Question: Condense the content of this figure into a single sentence.
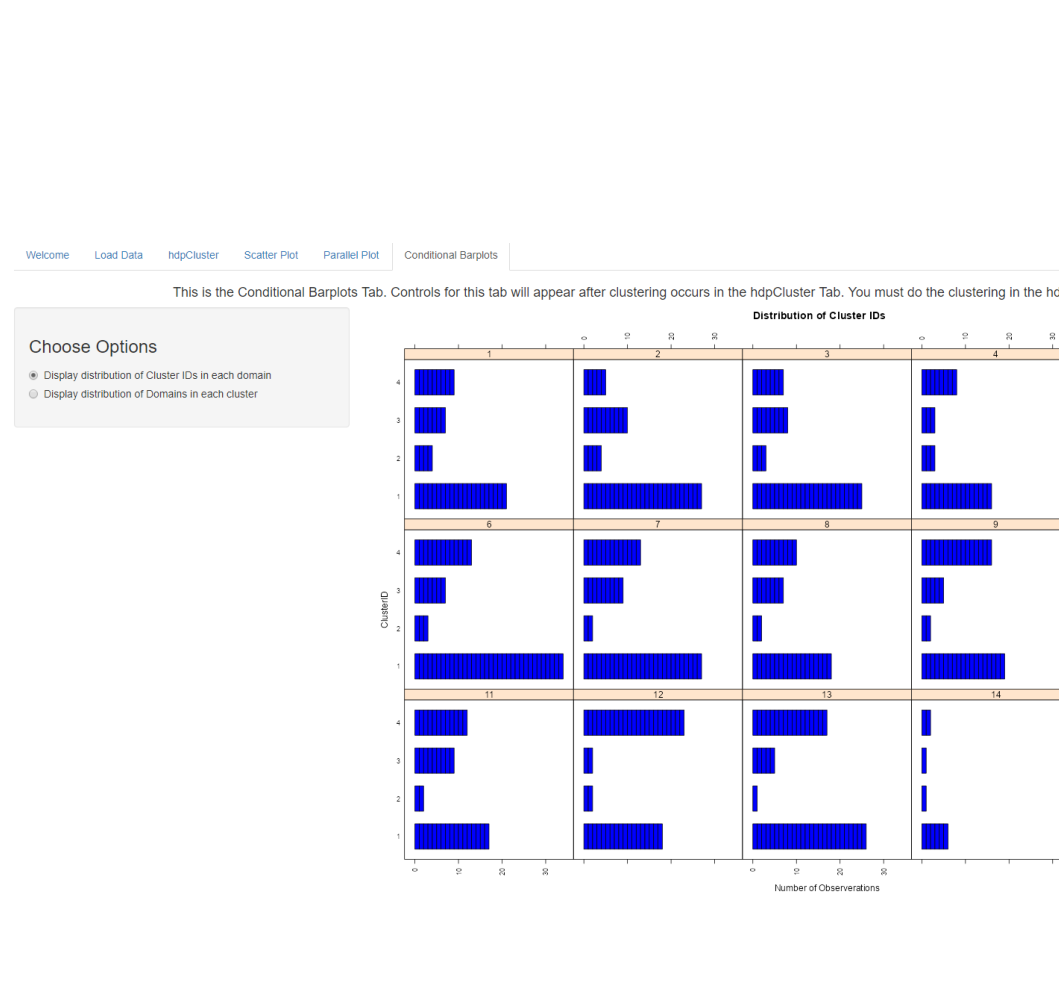
Answer: This is a screenshot of the hdpGrowclusters application Conditional  Barplot tab. When the first button is selected, we see the distribution of cluster id’s in each  domain.